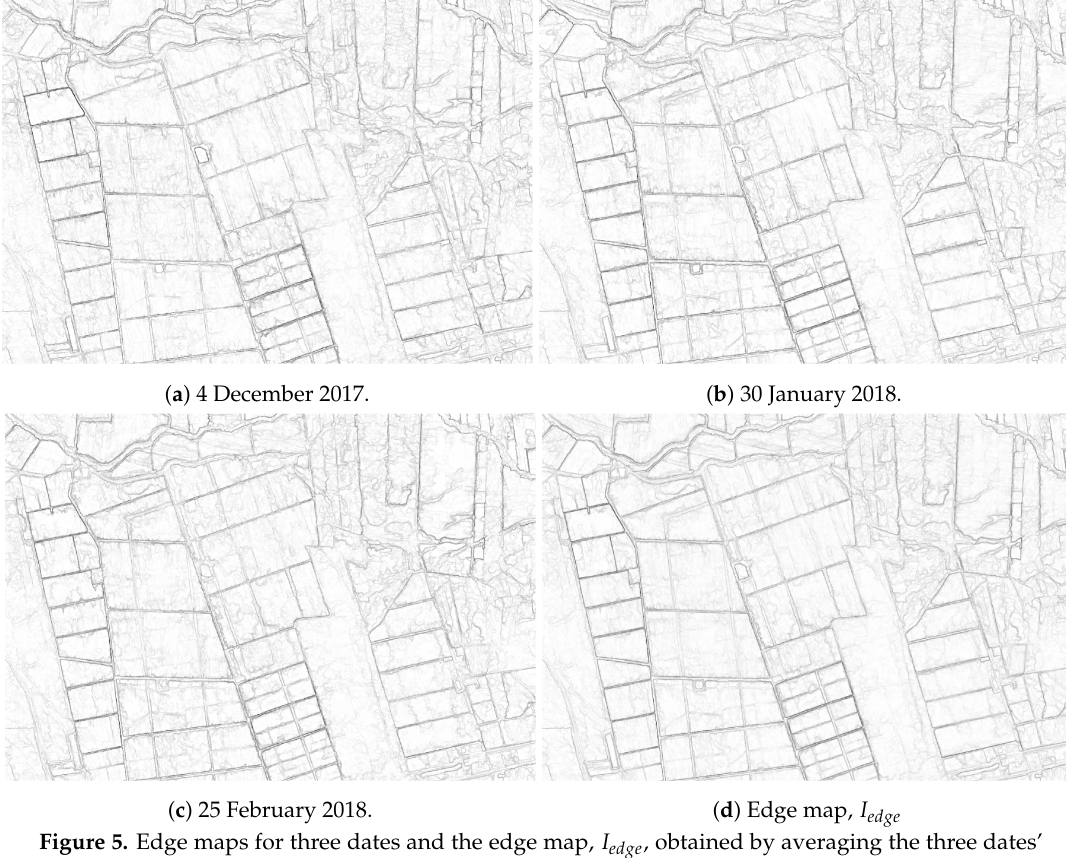
Figure 5. Edge maps for three dates and the edge map, I edge , obtained by averaging the three dates’ edge maps.